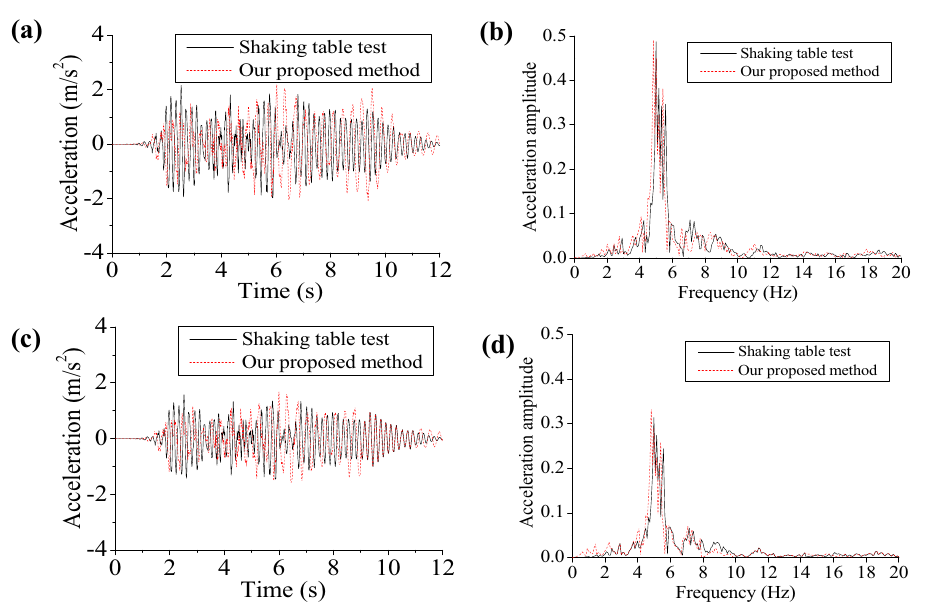
Figure 12. Time histories and Fourier spectra for acceleration in the presence and absence of ice influences: ( a ) acceleration influenced by ice; ( b ) Fourier spectrum influenced by ice; ( c ) acceleration without ice influence; ( d ) Fourier spectrum without ice